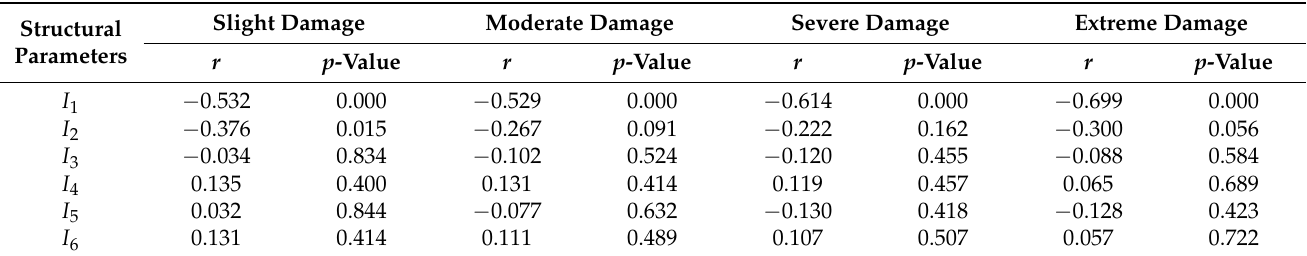
Table 2. Calculation results of correlation coefficient and p